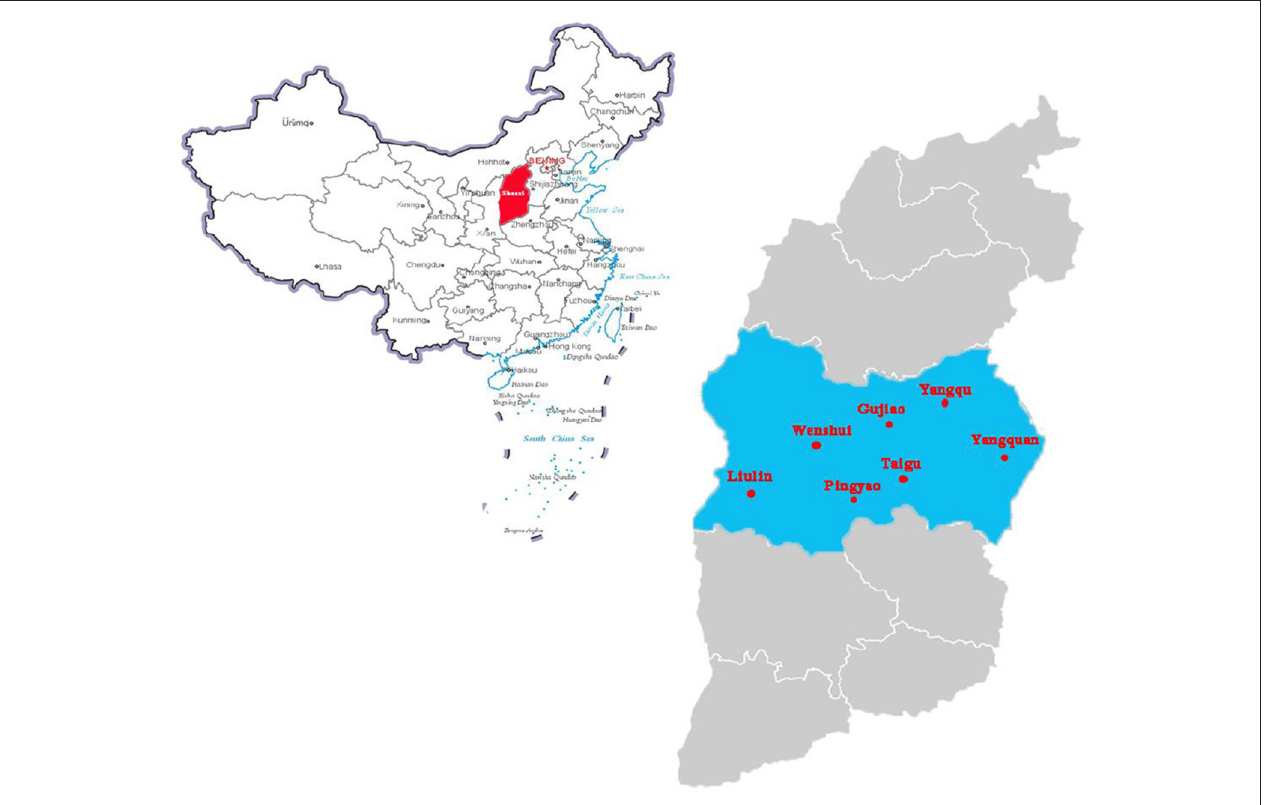
FIGURE 1 | Pig sampling locations in center of Shanxi Province, China. The standard map of China is obtained from the national standard map system (http://bzdt. ch.mnr.gov.cn/). Red area indicates where Shanxi province is in China. The blue area indicates the sampling collection cities, the scarlet letter indicates where the samples were collected in Shanxi province, China.